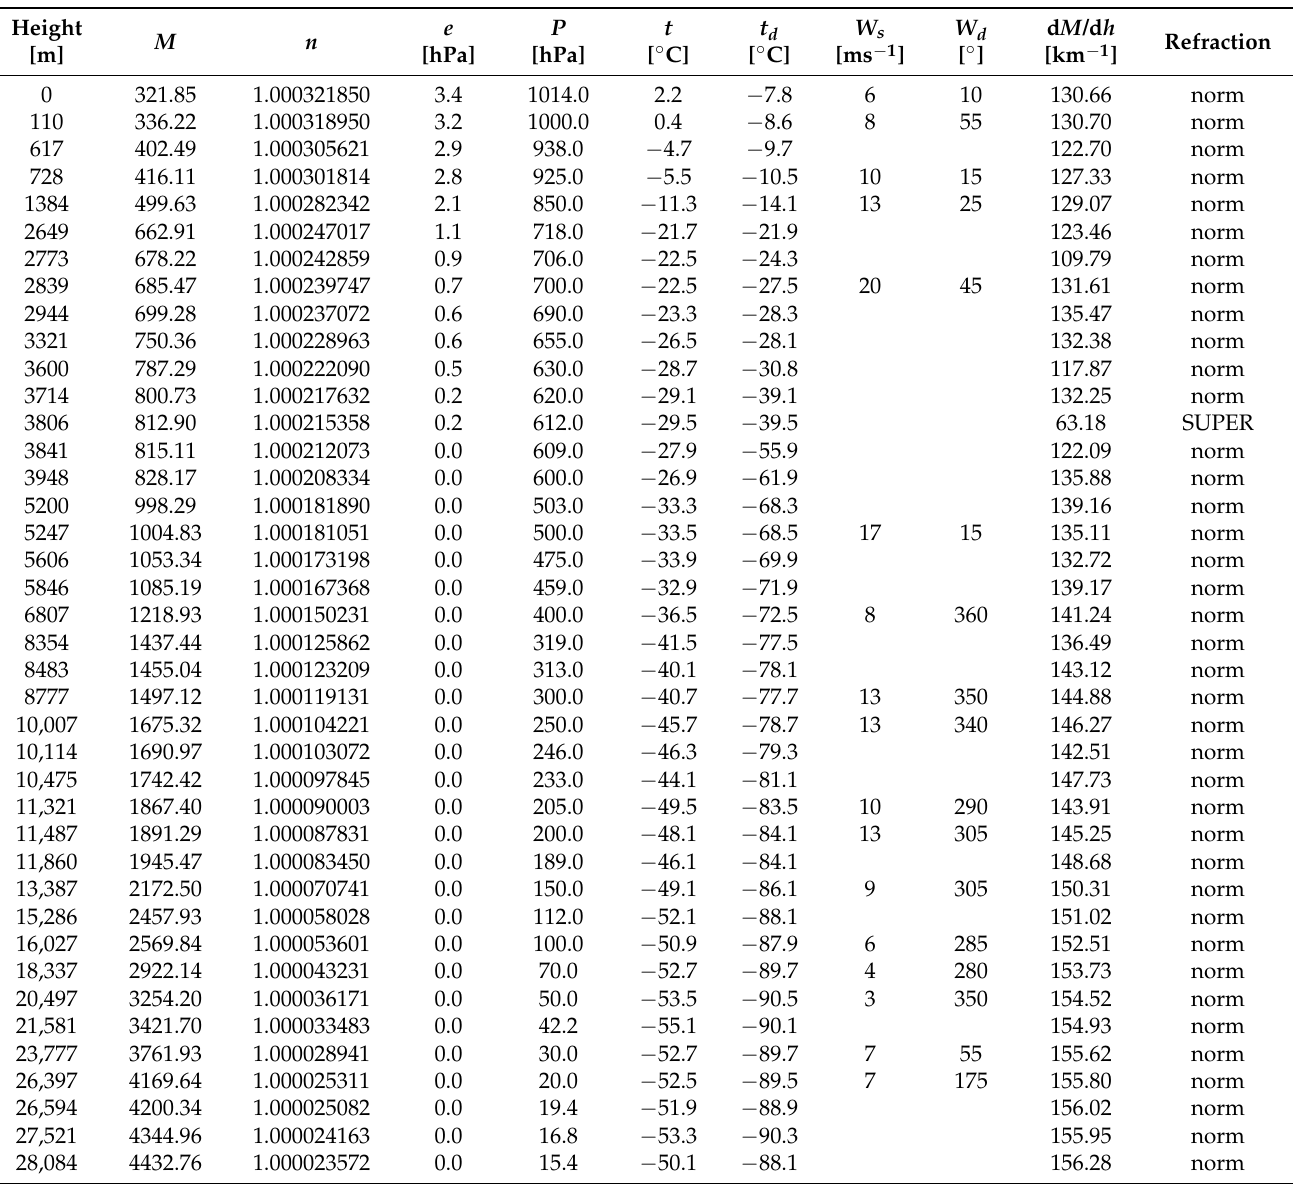
station Zagreb Maksimir (WMO index